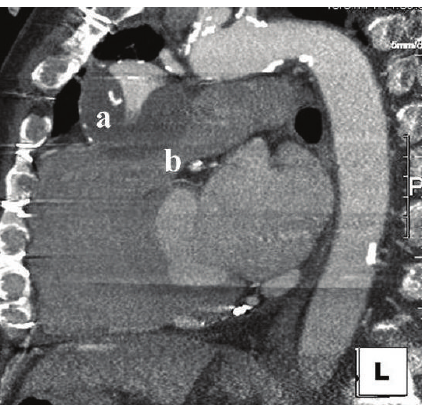
Figure 1: Coronary CT angiogram showing giant saphenous venous graft aneurysm (a) compressing the pulmonary artery (b).